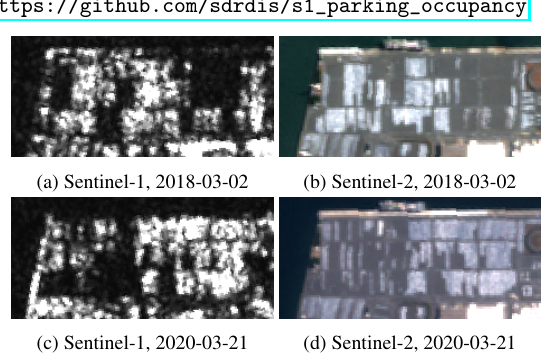
Figure 17. Sentinel-1 and Sentinel-2 images of the same parking (car producer in Japan). Sentinel-1 and Sentinel-2 are acquired on the same day but at different hours, hence differences in parking occupancy are to be